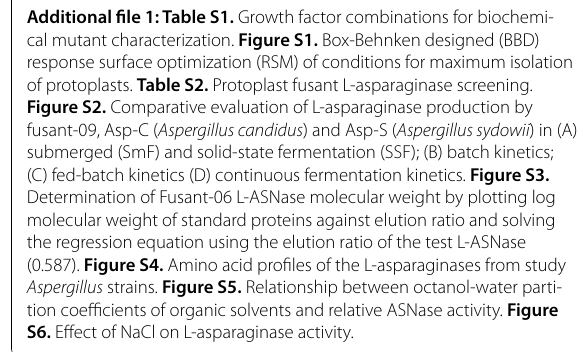
Additional file 1: Table S1. Growth factor combinations for biochemi- cal mutant characterization. Figure S1. Box-Behnken designed (BBD) response surface optimization (RSM) of conditions for maximum isolation of protoplasts. Table S2. Protoplast fusant L-asparaginase screening. Figure S2. Comparative evaluation of L-asparaginase production by fusant-09, Asp-C ( Aspergillus candidus ) and Asp-S ( Aspergillus sydowii ) in (A) submerged (SmF) and solid-state fermentation (SSF); (B) batch kinetics; (C) fed-batch kinetics (D) continuous fermentation kinetics. Figure S3. Determination of Fusant-06 L-ASNase molecular weight by plotting log molecular weight of standard proteins against elution ratio and solving the regression equation using the elution ratio of the test L-ASNase (0.587). Figure S4. Amino acid profiles of the L-asparaginases from study Aspergillus strains. Figure S5. Relationship between octanol-water parti- tion coefficients of organic solvents and relative ASNase activity.